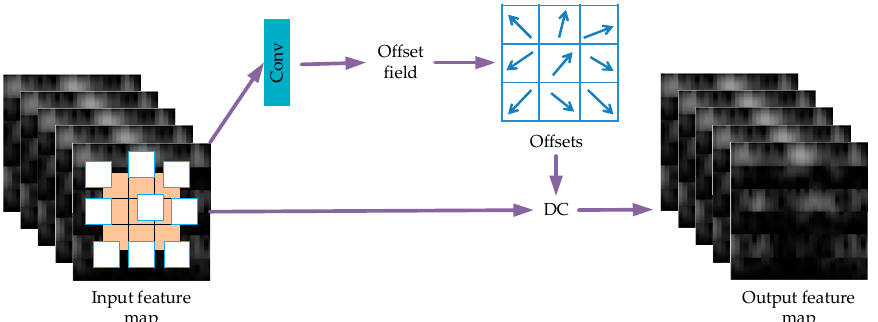
Figure 2. 3 × 3 Diagram of the deformable convolutional operation mechanism.